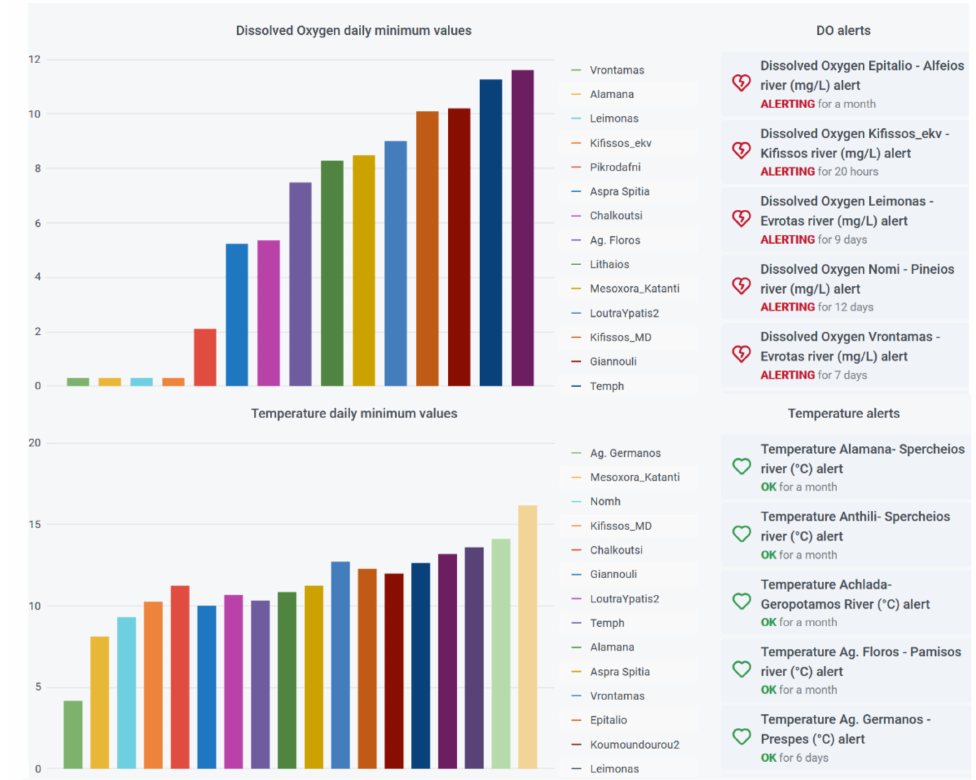
Figure 11. Bar charts of the minimum daily values for the physicochemical parameters of water dissolved oxygen (DO) and water temperature (T) measured from the monitoring network of stations (along with the active alerts for every station and parameter, as presented in the HCMR central visualization